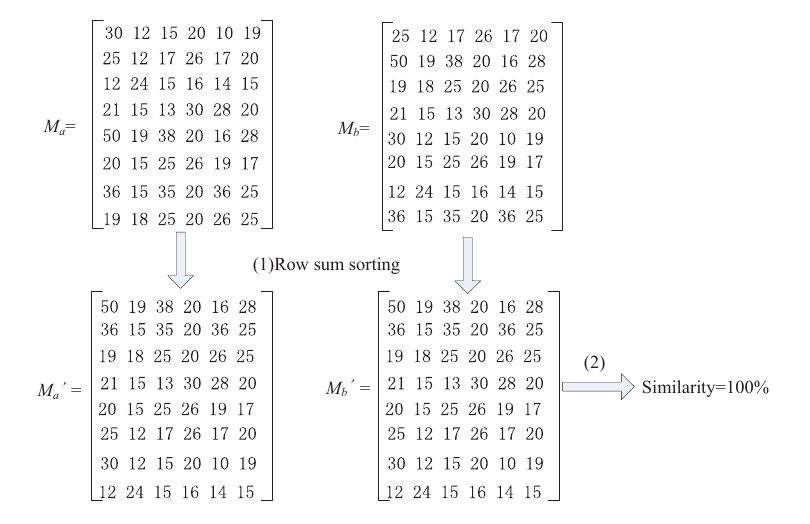
Figure 5. Example for the Row Sum Sorting (RSS)